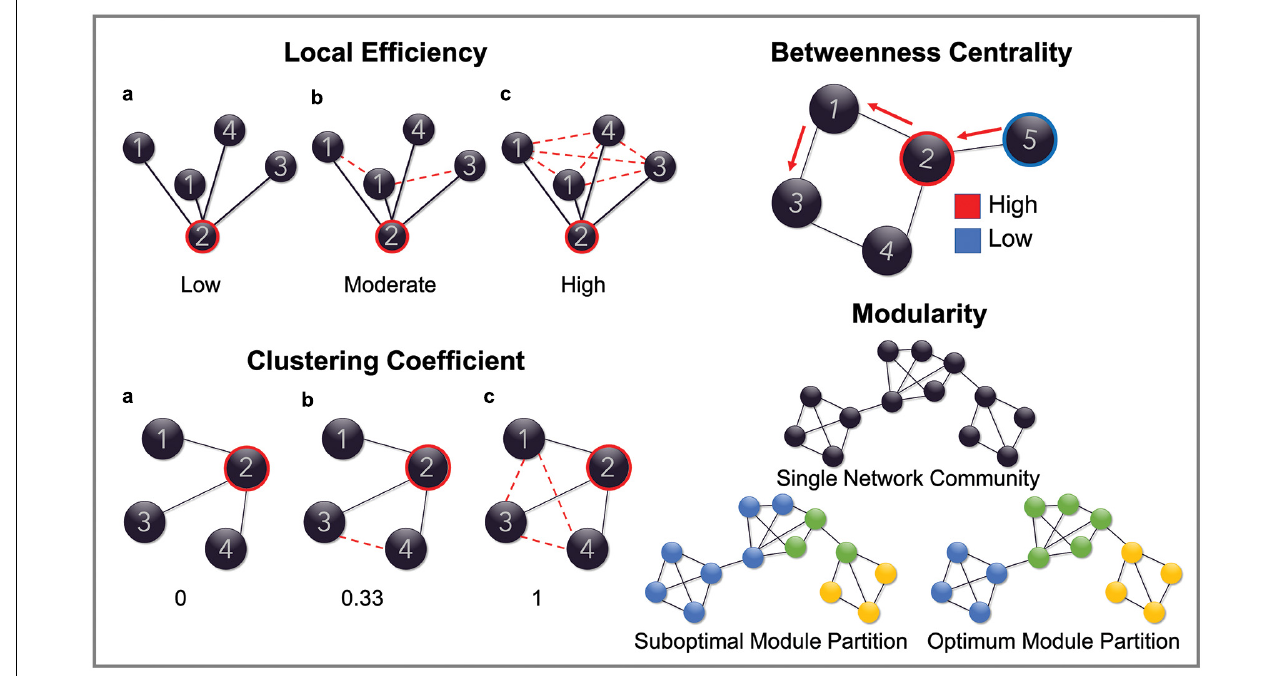
FIGURE 1 | Schematic representation of network parameters. Figures are provided demonstrating the graph properties of local efficiency, clustering coefficient, betweenness centrality and modularity. Global efficiency is omitted as this measure reflects the same calculation as local efficiency but computed on the entire graph. In the top left, the local efficiency for node ‘2’ is low in example a because the average path length (path between any two nodes with the least number of edges) between its neighboring nodes is reasonably high (all are connected by two edges). It is high in example c , however, because the average path length is much lower (all nodes are connected by one edge), therefore demonstrating a highly efficient network structure. Clustering coefficient is a similar measure. In this case, node ‘2’, in the first instance, has a clustering coefficient of 0 because none of its neighboring nodes (nodes that are connected to it by an edge) are connected to each other by an edge. This increases to 0.33 in example b , because 1/3 of its neighboring nodes are connected and finally increases to 1 in example c because all of its neighboring nodes are now connected. In the top right of the figure, the betweenness centrality of node ‘2’ is high because it is included in the shortest paths between node ‘5’ and all the other nodes in the network. Node ‘5,’ however, has a low betweenness centrality as it is not included in the shortest paths between any of the other nodes. Finally, modularity is demonstrated in the bottom left by showing what constitutes an optimal modular structure.